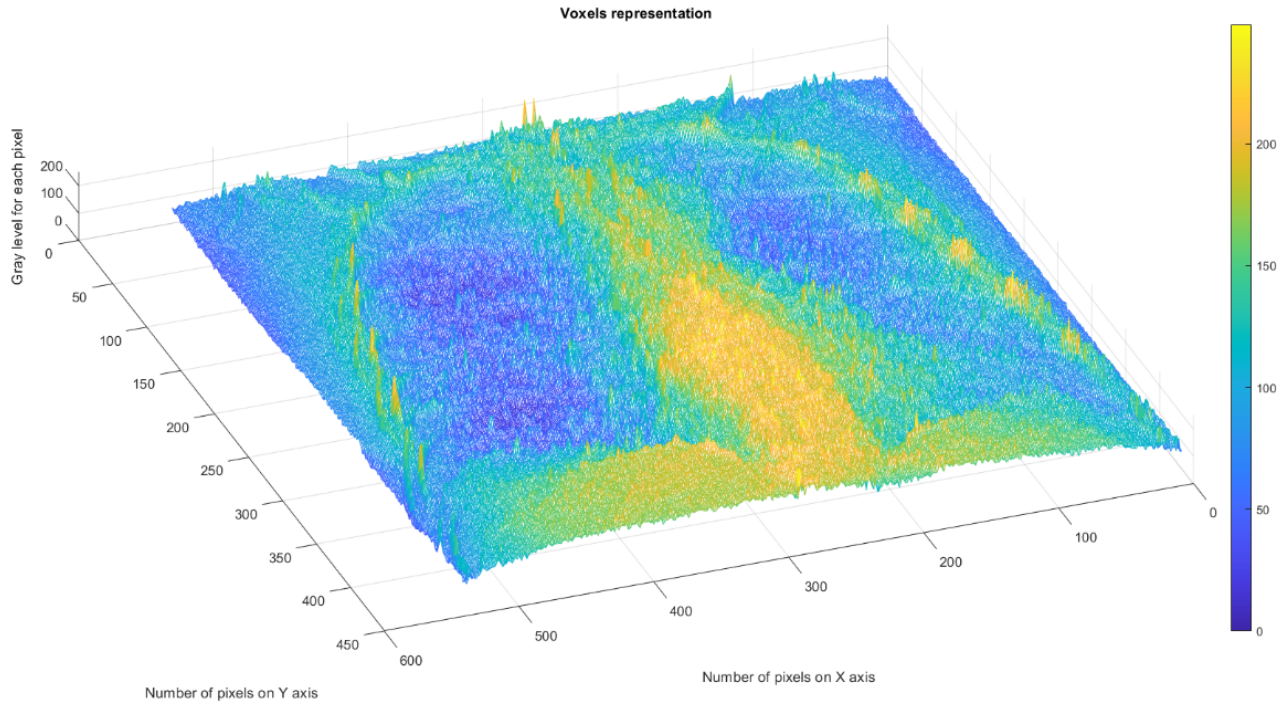
Figure 6. Three-dimensional graphical representation of voxels in the first patient’s CT lung im- age.